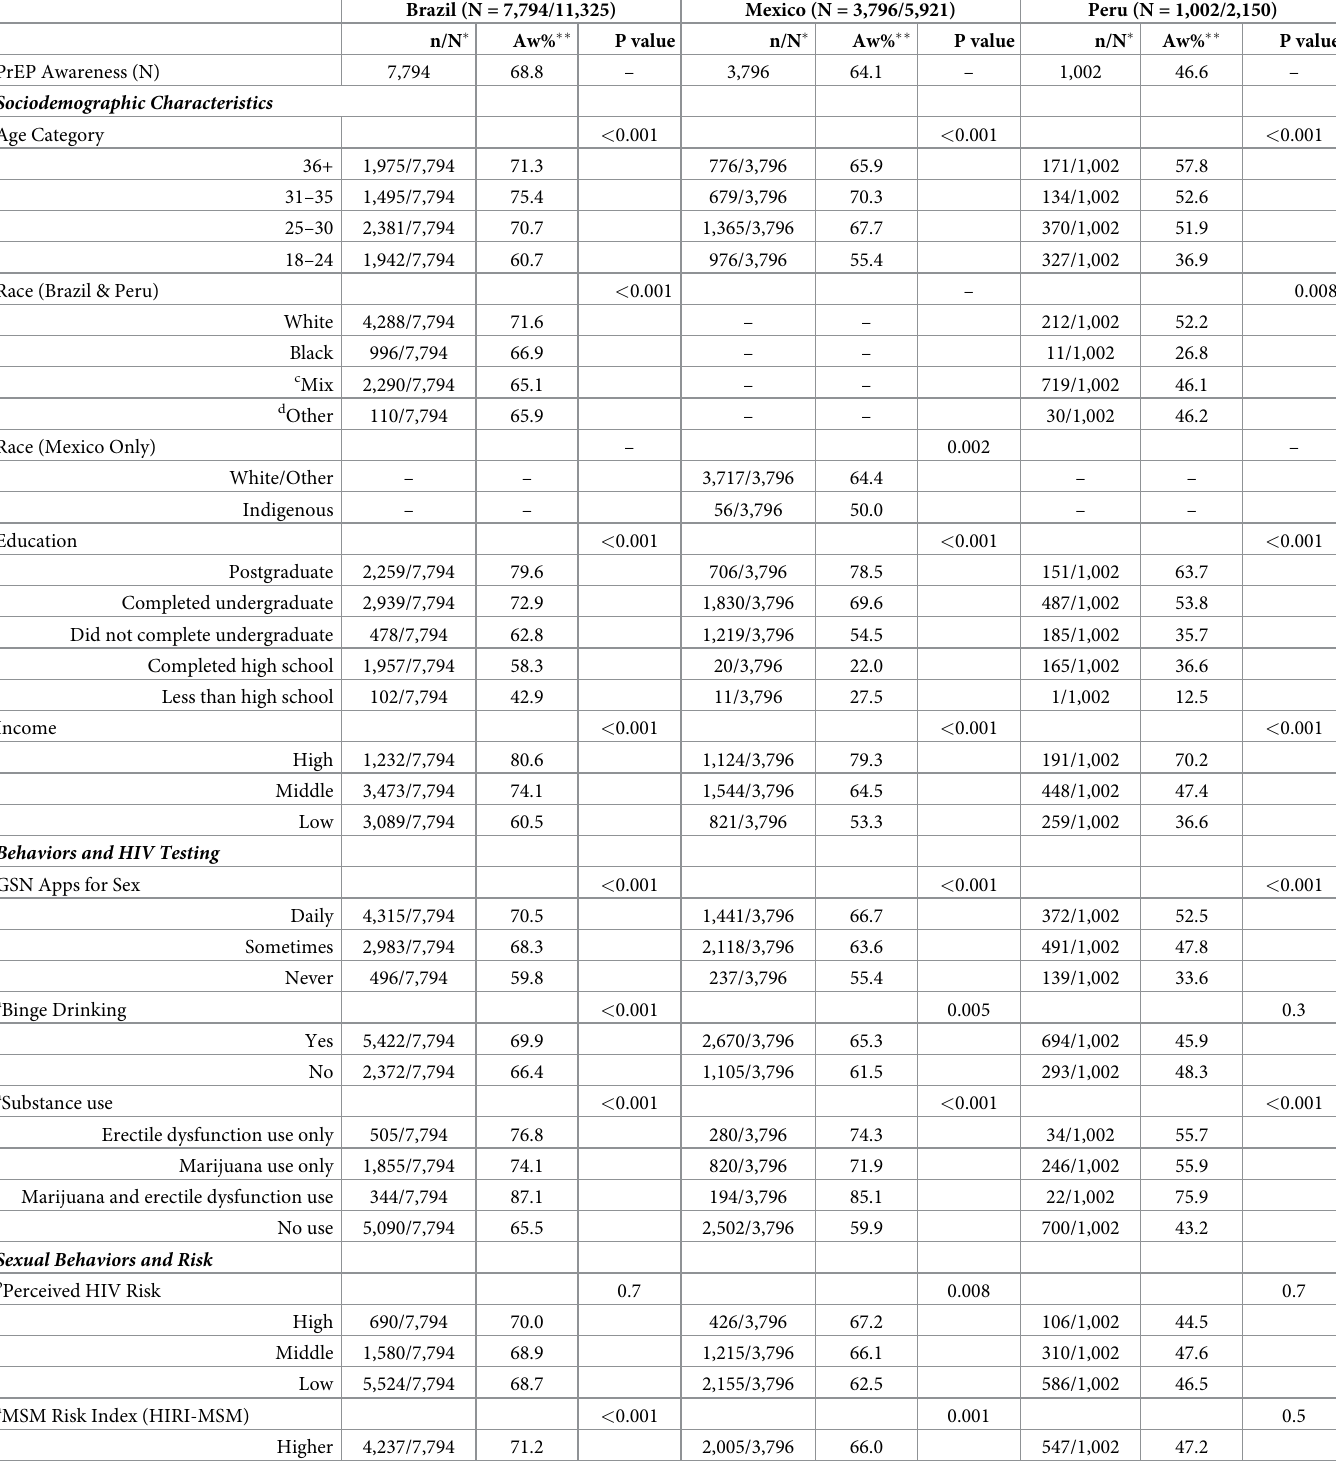
Table 1. Frequency distributions of PrEP awareness by demographics and behaviors compared to those not aware of PrEP: Brazil, Mexico, Peru (N = 19,457) April,